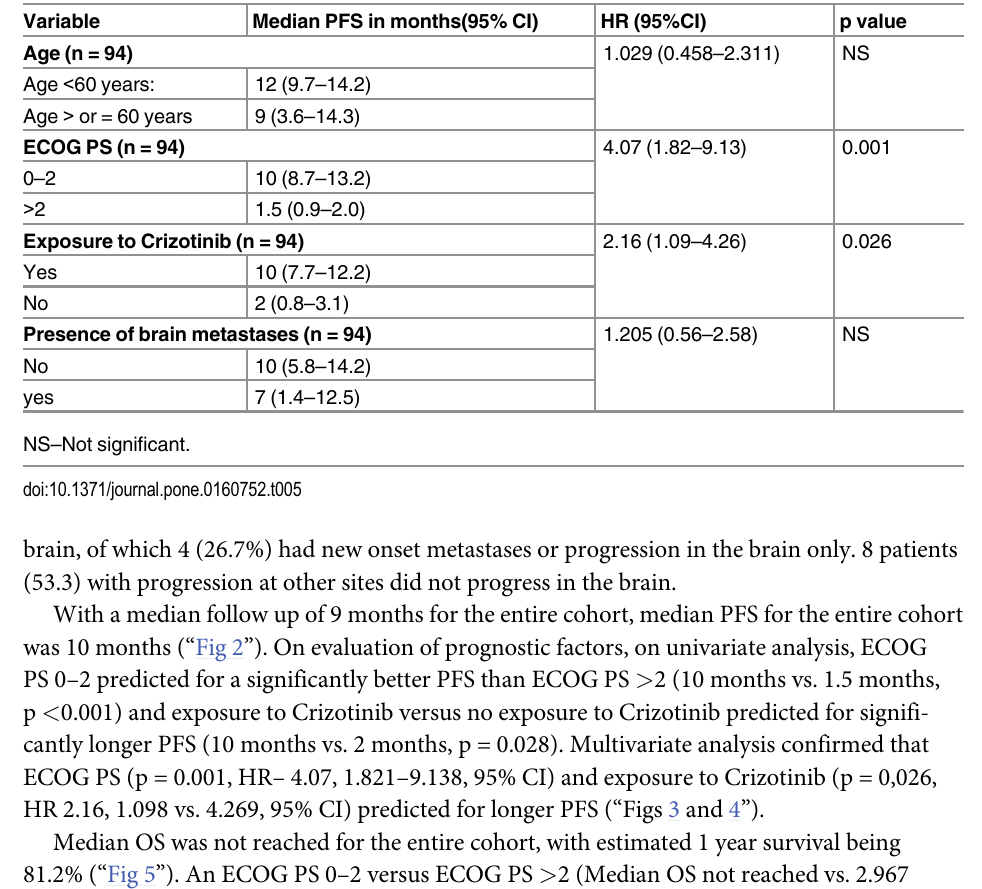
Table 5. PFS and Prognostic factors.